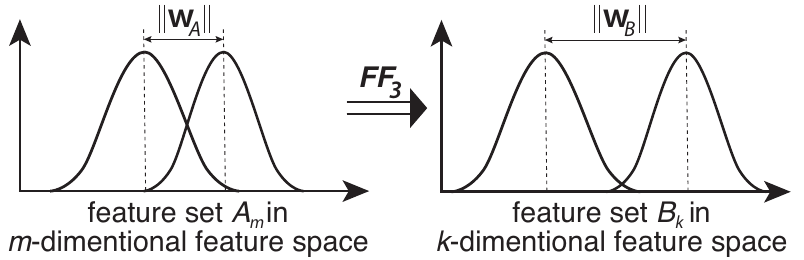
Figure 3. Optimization function FF 3 in terms of set distribution, where the set B k ∈ A m , k ≤ m and m is the number of all